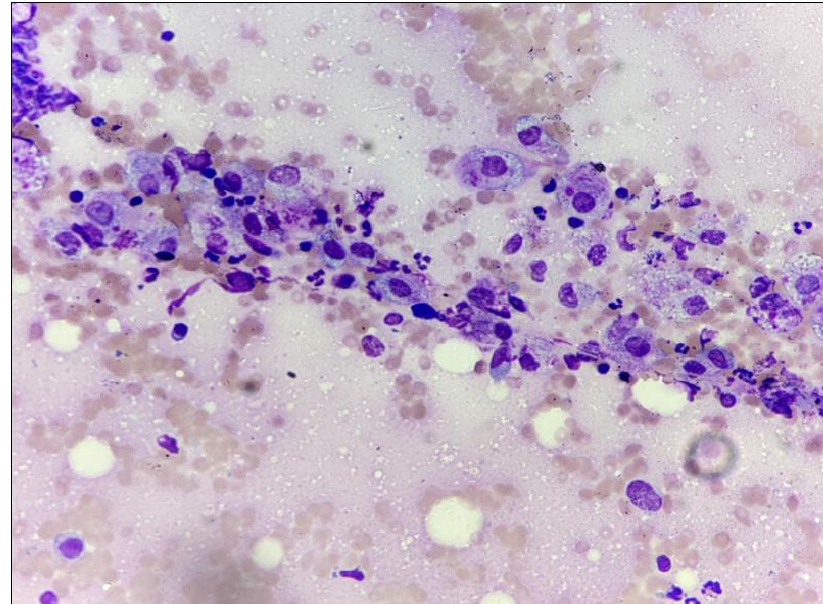
Fig. 2. FNAC of Chronic Sialadenitis showing inflammatory cells with plump epithelial and myoepithelial cells against a hemorrhagic and fibromyxoid stroma (H&E, 400X). Warthin's tumour showed sheets of oncocytic cells that were uniform granular amorphous substance and plenty of lymphocytes were seen in the with regular round nuclei and abundant cytoplasm. Thin cystic material to background (Fig.